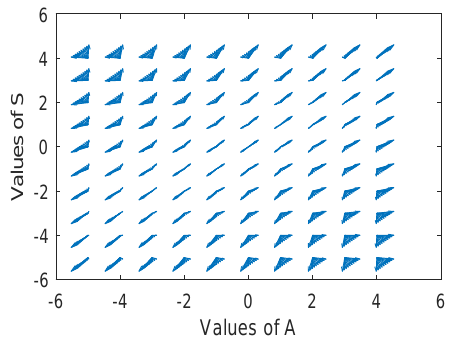
Figure 11. Phase portrait for differential Equation